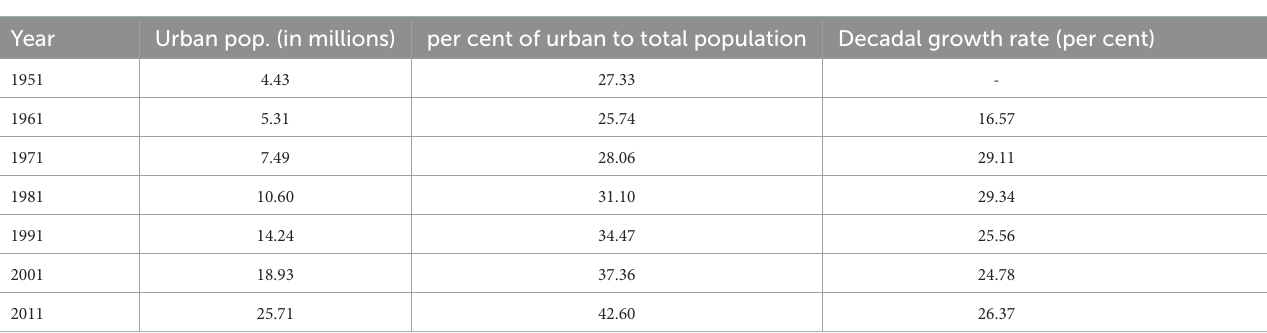
TABLE 2 Decadal growth rate of urban population, Gujarat-1951 to 2011.